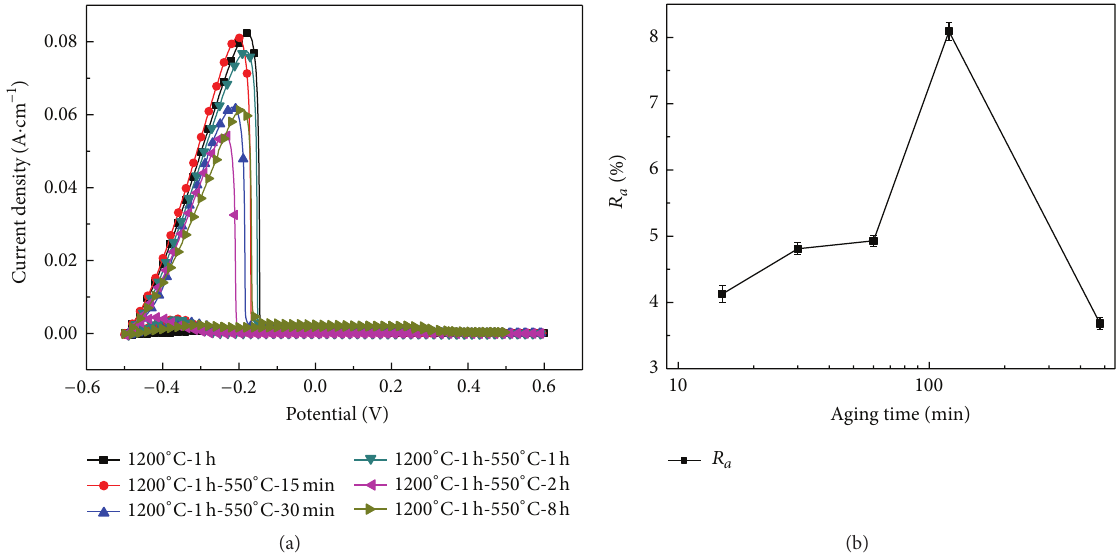
Figure 5: DL-EPR curves and 𝑅 𝑎 values of FSS 429 aging at 550 ∘ C for different time.